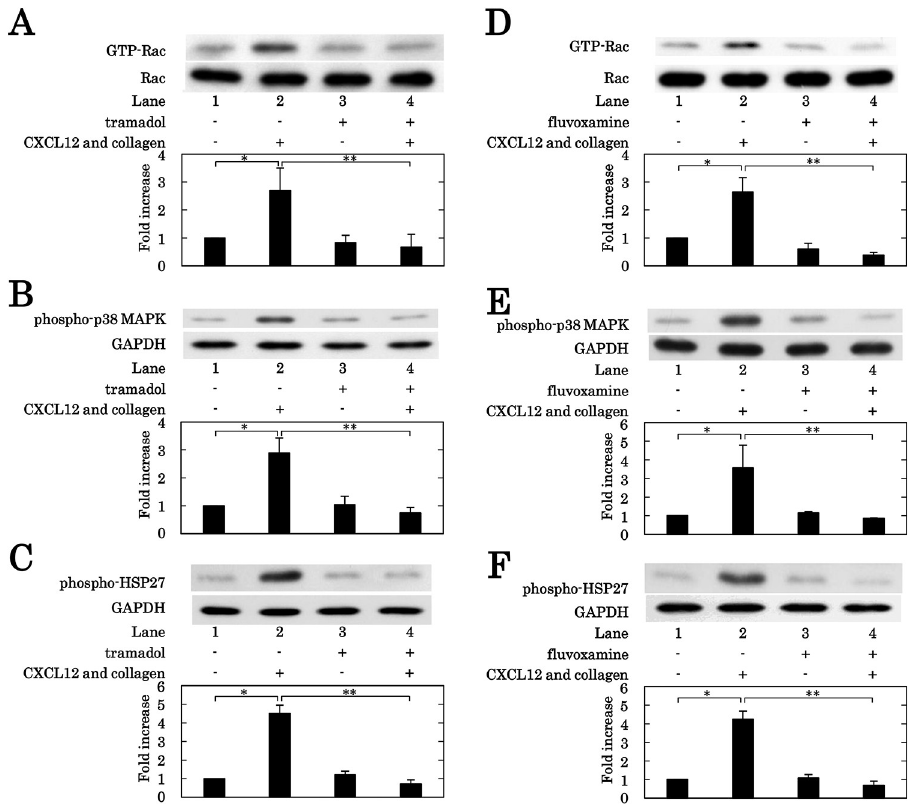
Fig 5. Effects of tramadol or fluvoxamine on the levels of GTP-binding Rac, the phosphorylation of p38 MAPK and the phosphorylation of HSP27 in human platelets induced by simultaneous stimulation with collagen and CXCL12. PRP was pretreated with 300 μ M of tramadol (A, B, C), 30 μ M of fluvoxamine (D, E, F) or vehicle for 3 min, and then simultaneously stimulated by 0.075–0.45 μ g/ml of collagen and 10 ng/ml of CXCL12 for 90 seconds (A, D) or 180 seconds (B, C, E, F). The reaction was terminated by the addition of ice-cold EDTA (10 mM) solution. (A, D) The protein extracts were harvested as described in Materials and methods, and then GTP-binding Rac was immunoprecipitated using the Rac1 activation assay kit. The immunoprecipitated GTP-binding Rac and pre- immunoprecipitated lysates (Rac) were subjected to Western blot analysis using antibodies against Rac. (B, C, E, F) The levels of phosphorylated p38 MAPK or phosphorylated HSP27 in the cell lysate of platelets were determined by the Western blot analysis using anti-phospho-p38 MAPK antibodies (B, E), anti-phospho-HSP27 (Ser-78) antibodies (C, F) or anti-GAPDH antibodies. Each histogram shows a quantitative representation of the stimulation with collagen and CXCL12-induced levels obtained from a densitometric analysis. The density levels are expressed as the fold increase compared to the levels of vehicle, presented as lane 1. Each value represents the mean ± SEM of 3 times independent experiments. � p < 0.05, compared to the value of vehicle. �� p < 0.05, compared to the value of simultaneous stimulation of collagen and